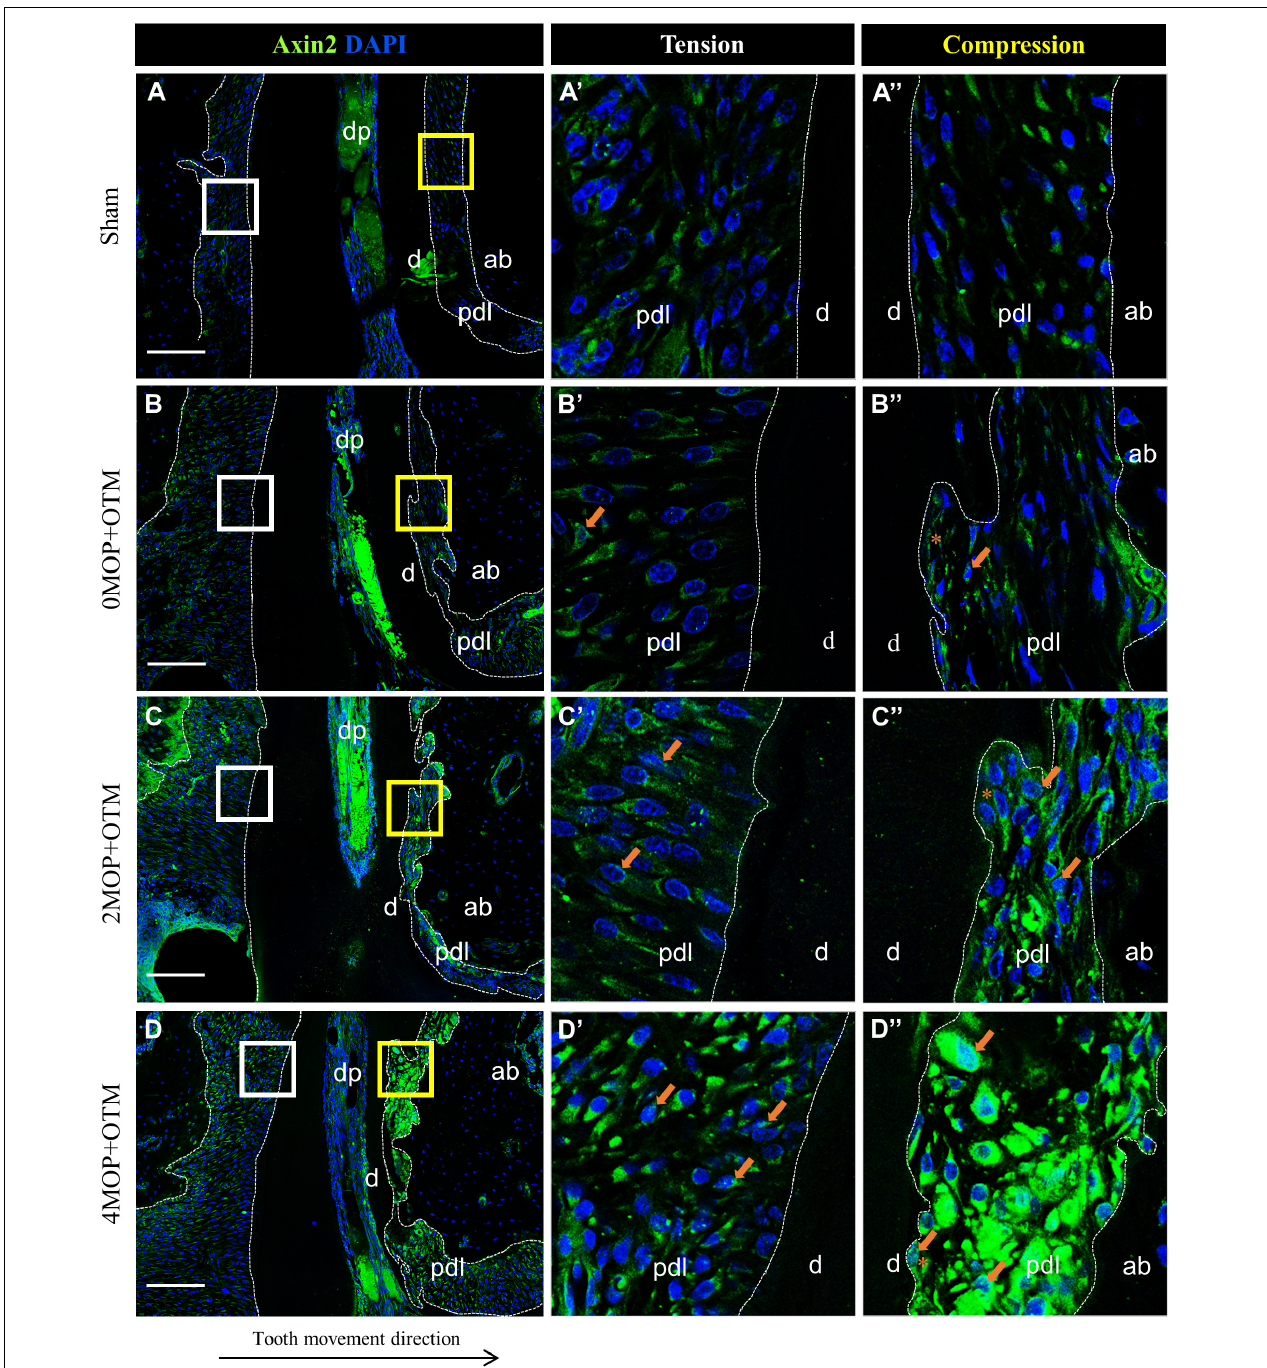
FIGURE 5 | Differential expression of Axin2 dependent to the number of MOP. Wnt signaling regulator, Axin2 expression was detected in PDL area surrounding distal root. (A) In sham group, Axin2 was evenly expressed in both sides of PDL. (A’) High magnification of tension side ( white box of A ) and (A”) compression side ( yellow box of A ) PDL of the Sham group. (B) Axin2 expression in 0MOP+OTM group. (B’) High magnification of tension side ( distal ) and (B”) compression side ( mesial ) side of PDL. Relatively stronger expression of Axin2 ( arrow ) than the surrounding area was observed on root resorption area. (C) Axin2 expression in 2MOP+OTM group. (C’) In tension side, Axin2 expression was slightly increased than 0MOP+OTM group. (C”) In compression side, moderate to strong expression was observed ( arrows ). (D) In 4MOP+OTM group, Axin2 expression was increased compared to other groups. The expression was stronger at root resorption area of compression side. (D’) The tension side showed moderate to strong expression. (D”) The compression side, intensively strong expression of Axin2 was detected. (Dashed lines, outlines of PDL area; d, dentin; p, periodontal ligament; ab, alveolar bone; dp, dental pulp; asterisks ( ∗ ) indicate root resorption area; arrow, examples of single stained cells; Scale bars = 100 µ